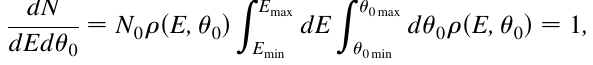
When r decreases, the width of the peaks decreases too and a spectrum of lines is approached. When the value of (cid:7) decreases the peaks become larger and a background is progressively created because the particles almost parallel to the z axis cross the collimators, whatever their energy. In Fig. 13 we show the function g ð E Þ for two different values of (cid:7) equal to 0.001 and 0.005, respectively 0min